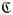
Spearman’s rank correlation coefficient of C and S (left) and of C and Φ (right) in TreeBASE, as functions of the trees’ numbers of leaves n.